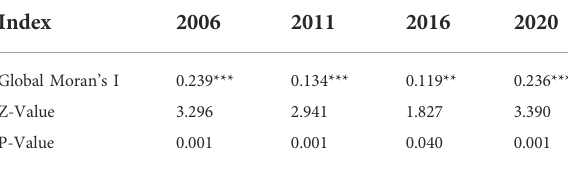
TABLE 2 Global Moran ’ s I of the eco-ef fi ciency of RED in the study area.